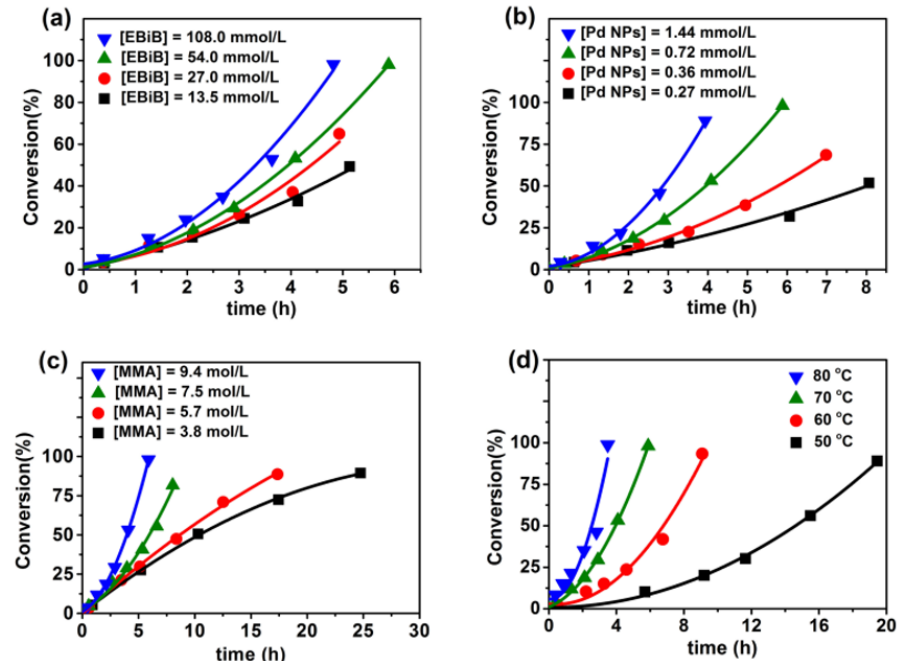
Figure 2. Conversion-time plots of the polymerization of MMA at di ff erent 2-bromoisobutyric acid ethyl ester (EBiB) concentrations ( a ), Pd NP concentrations ( b ), monomer concentrations ( c ), and di ff erent temperatures ( d ). Reaction conditions: ( a ) [MMA] = 9.4 mol / L, [Pd NP] = 0.72 mmol / L, T = 70 ◦ C; ( b ) [MMA] = 9.4 mol / L, [EBiB] = 54.0 mmol / L, T = 70 ◦ C; ( c ) [EBiB] = 54.0 mmol / L, [Pd NP] = 0.72 mmol / L, T = 70 ◦ C; ( d ) [MMA] = 9.4 mol / L, [EBiB] = 54.0 mmol / L, [Pd NP] = 0.72 mmol /